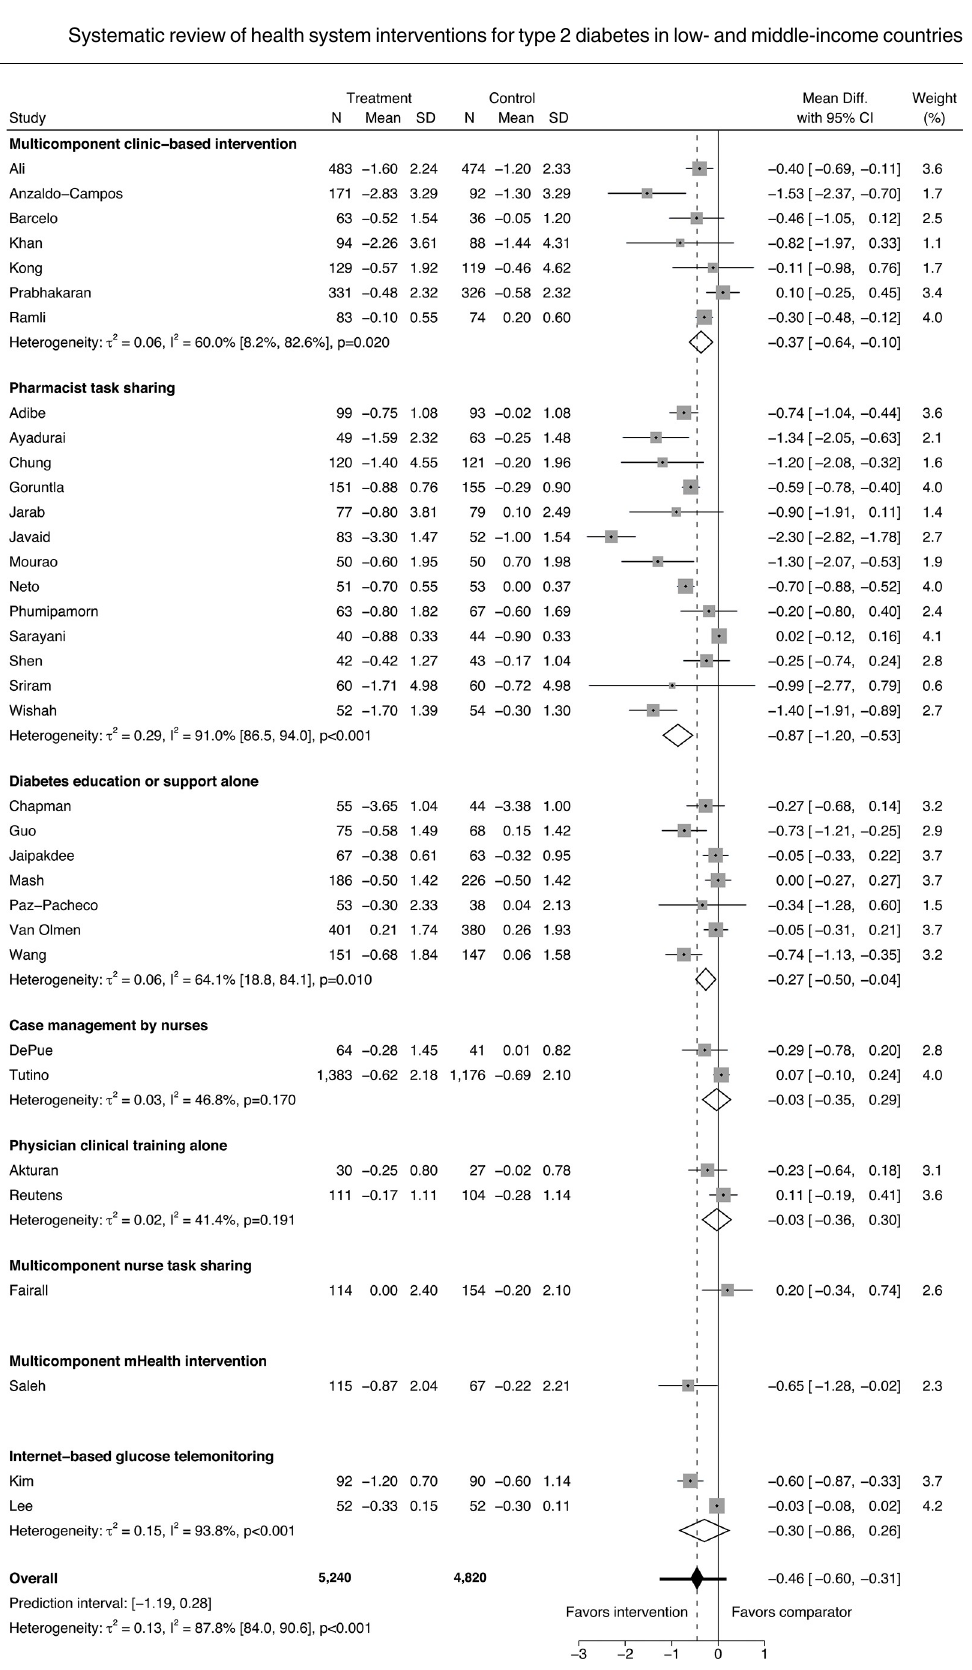
Fig 2. Forest plot for meta-analysis of hemoglobin A1c (%) mean difference.